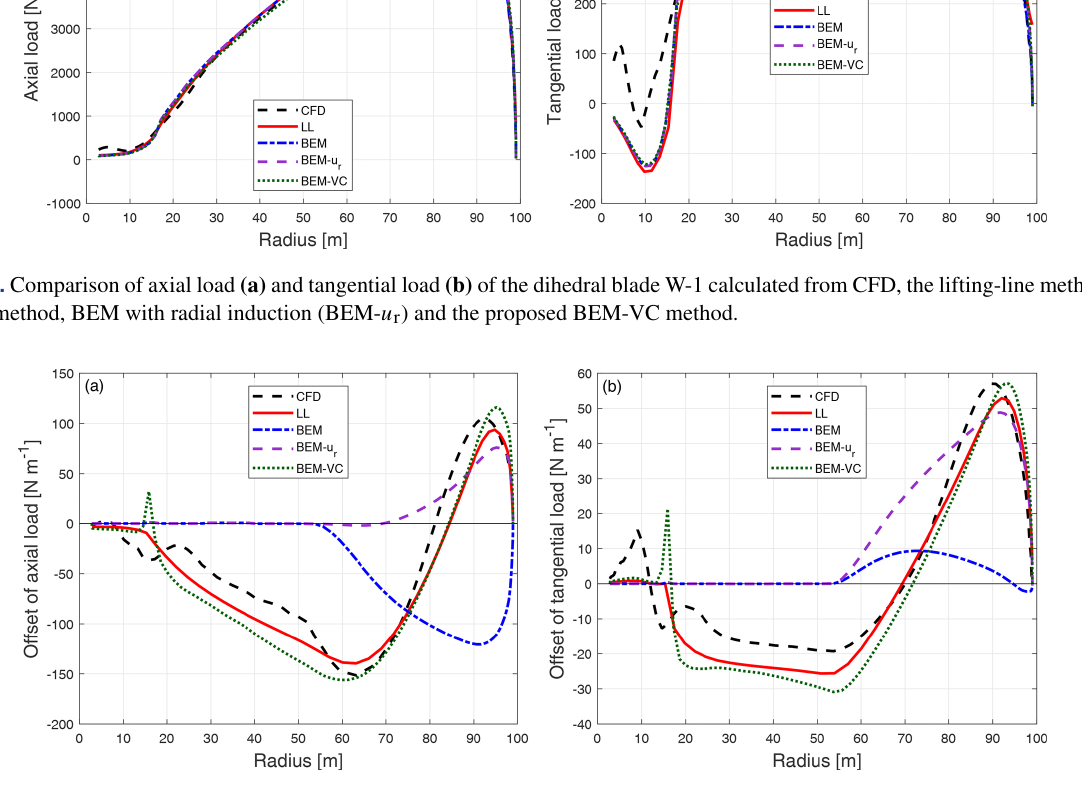
Figure 12. Comparison of the difference of the axial load (a) and tangential load (b) of the dihedral blade W-1 compared to the baseline blade calculated from CFD, the lifting-line method (LL), the BEM method, BEM with radial induction (BEM- u r ) and the proposed BEM-VC